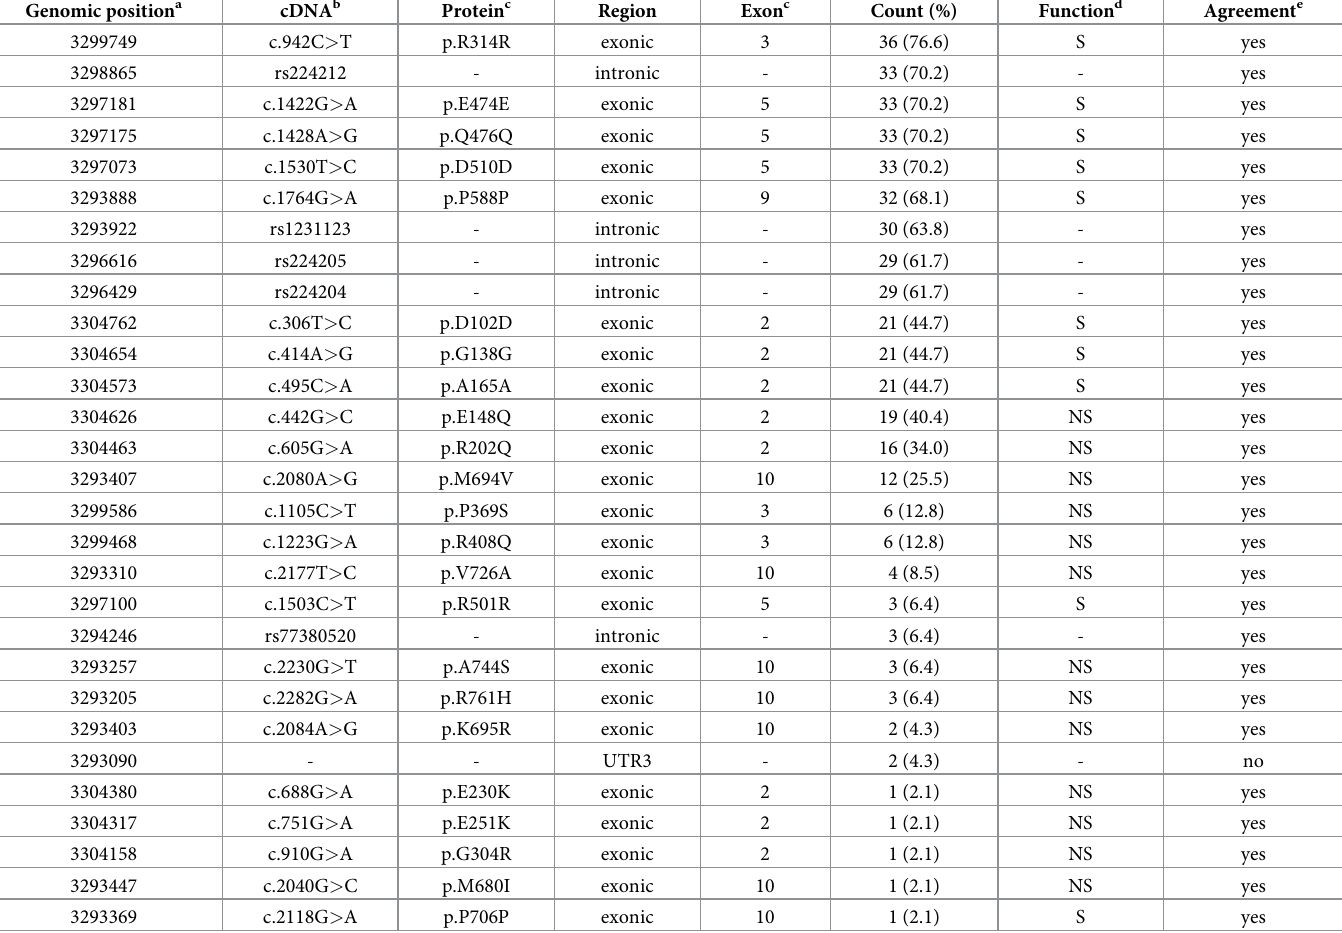
Table 1. Unique MEFV variants identified in 47 patients. Variant frequency in the sample collective under investigation is shown. One variant in two patients was only identified by Nanopore sequencing and could not be confirmed by initial Sanger